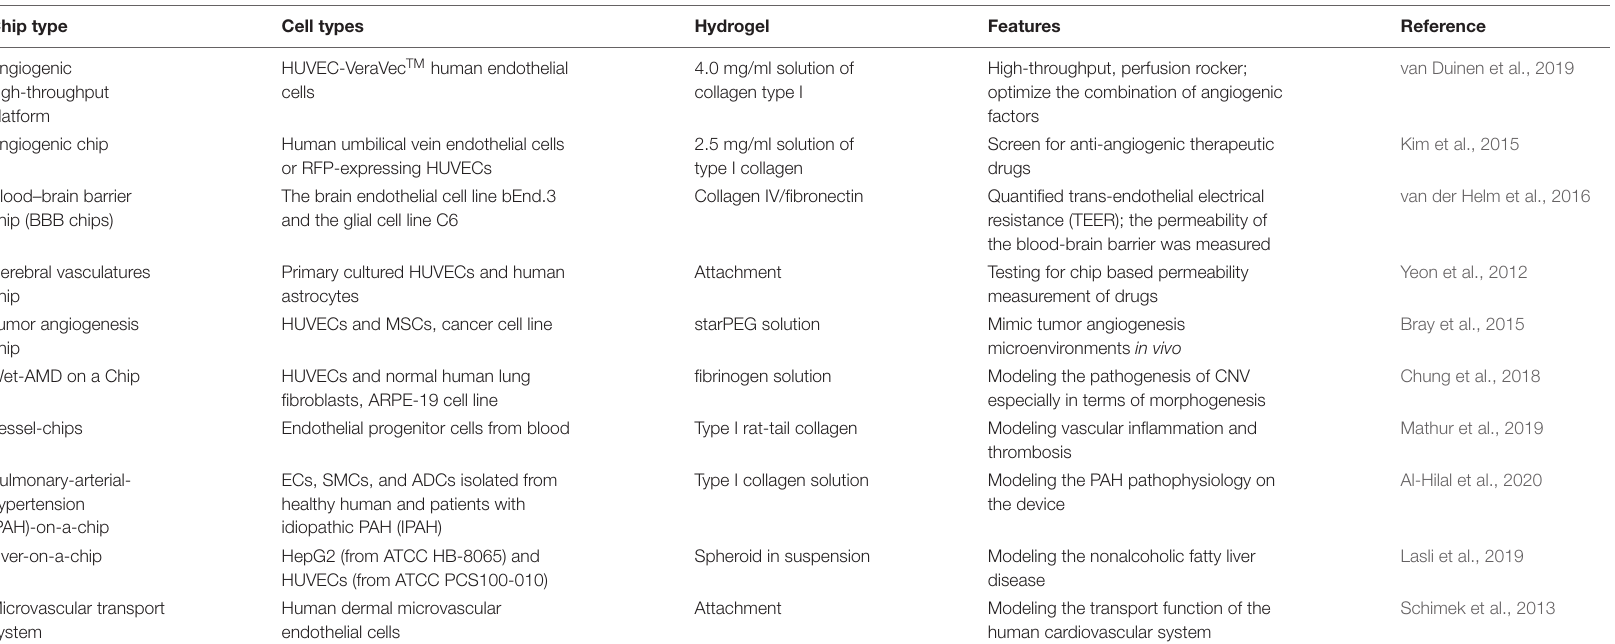
TABLE 1 | Build the blood vessels in different organ and different type of “organ on the